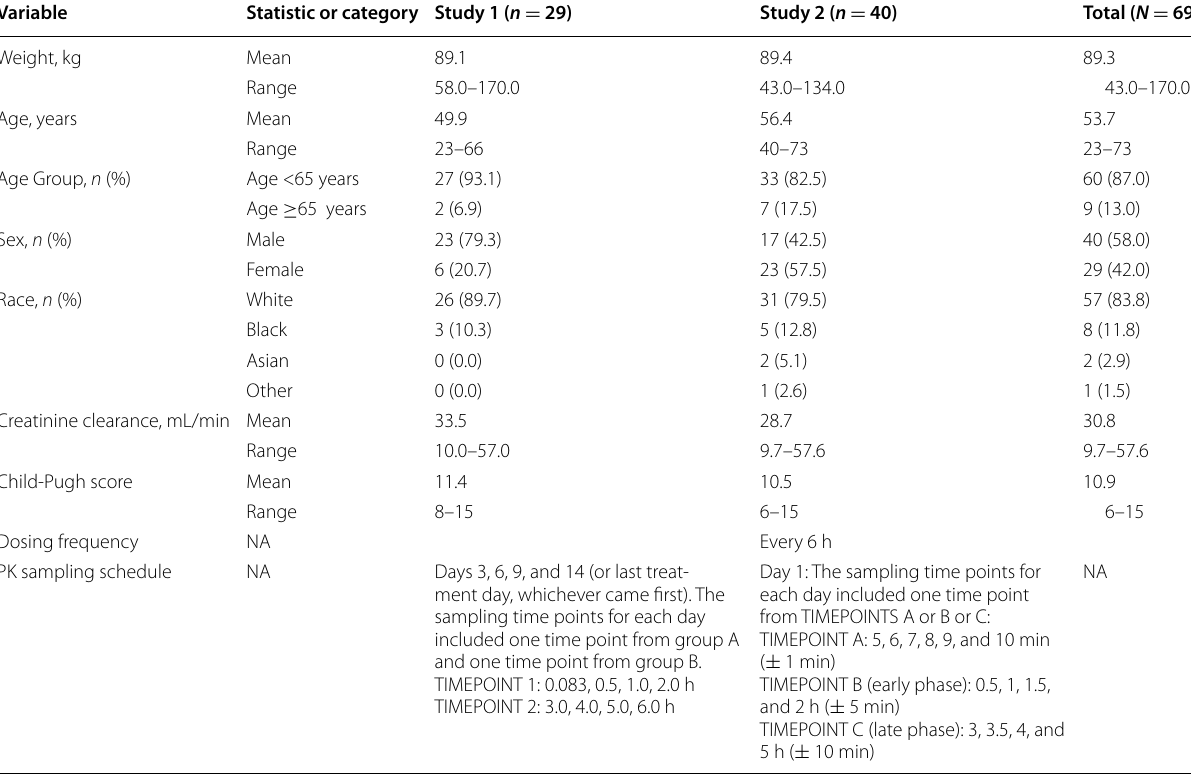
HRS, hepatorenal syndrome ; NA , not applicable; PK ,